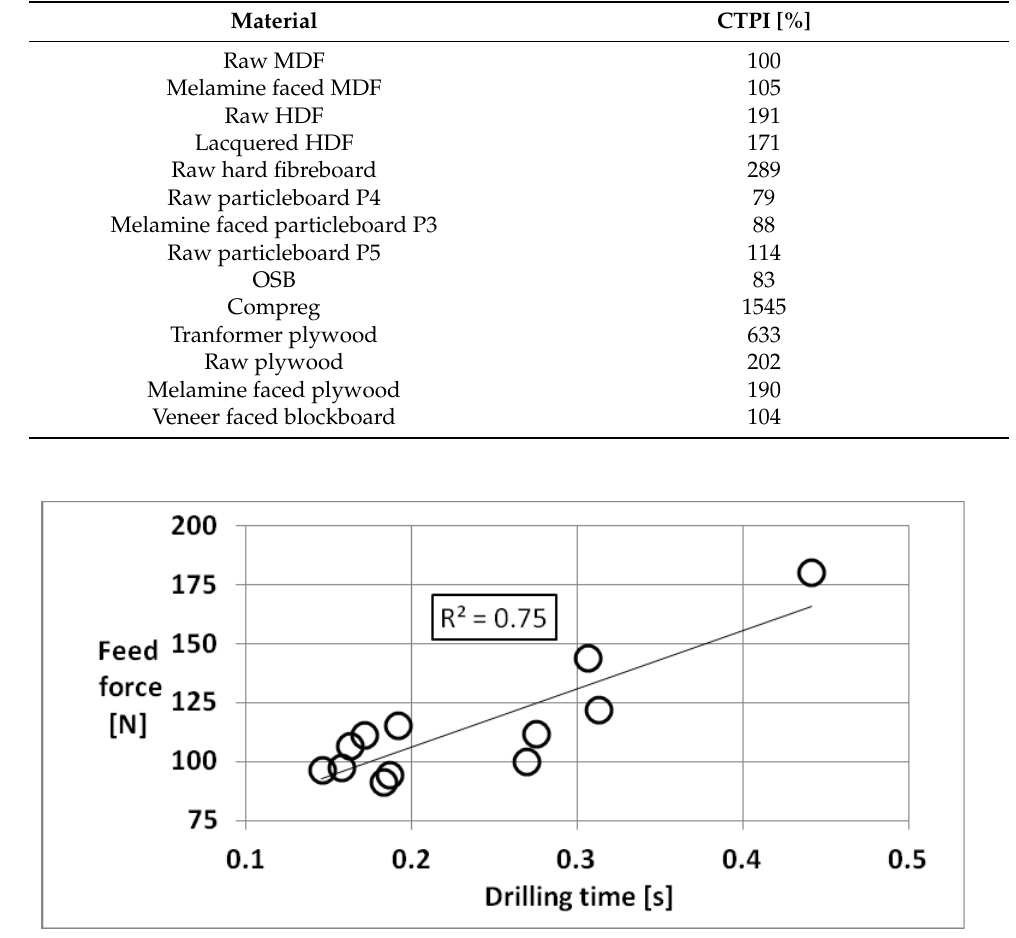
Figure 8. The relationship between the averaged time needed to make a 10 mm deep hole (drilling time) and the averaged feed forces, measured during the earlier, significantly reliable machinability testing [12] without taking into account the compreg and transformer plywood.